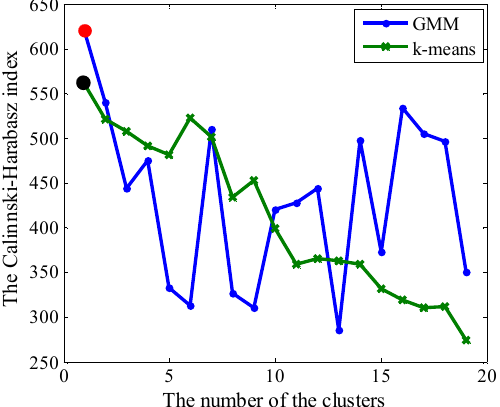
Figure 7. The comparison of Calinnski-Harabasz index of two different clustering methods.